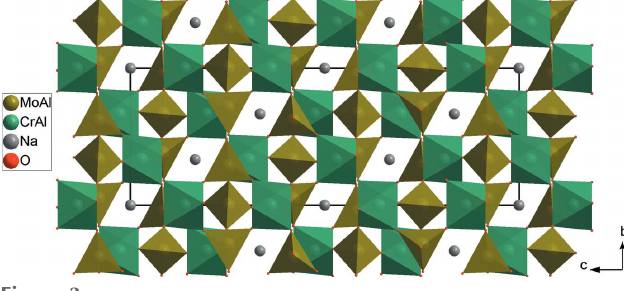
Figure 3 Projection of Na 0.72 (Cr 0.48 ,Al 1.52 )(Mo 2.77 ,Al 0.23 )O 12 along the a axis.